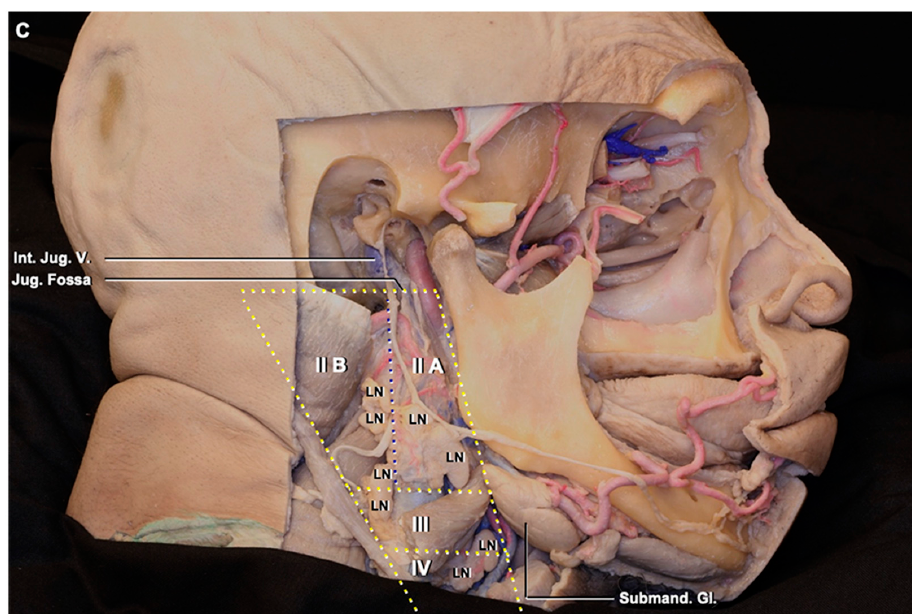
Figure 1. Stepwise dissections of the face and neck. ( A ), parotid gland was exposed after removal of facial skin and subcutaneous fat tissue. In the neck, the sternocleidomastoid muscle except its posterior edge, and platysma have been removed to expose the internal jugular vein and deep cervical lymph nodes. ( B ), after removal the external ear, mastoid bone, and parotid gland. The deep cervical lymph nodes are exposed. ( C ), groups of the deep cervical lymph nodes. The deep cervical lymph nodes are located in groups II, III, and IV in the neck. Abbreviations: CN, cranial nerves; DCLNs., deep cervical lymph nodes; Ext., external; Gl., gland; Int., internal; Jug., jugular; LN., lymph node; SCM, sternocleidomastoid muscle; Submand., submandibular; V., vein.